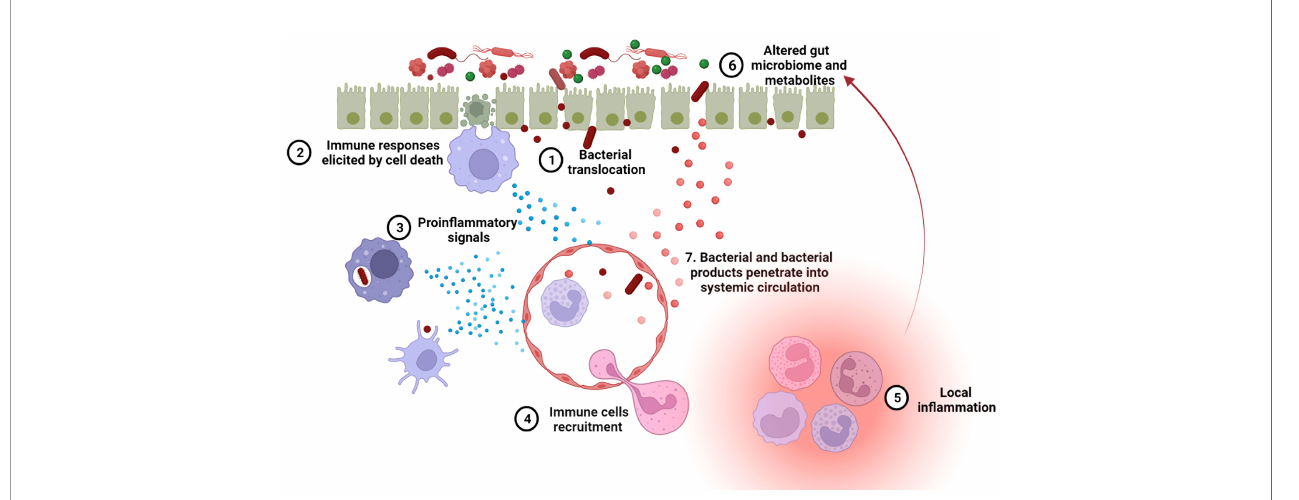
FIGURE 3 | A leaky gut exacerbates lupus progression. 1. Leaky gut-mediated bacterial translocation has been linked to the initiation of autoimmune responses. 2. Increased enterocyte cell death in leaky gut activates innate immune cells, inducing an overactive immune system. 3. The phagocytosis of invading bacteria by innate immune cells promotes in fl ammation. 4. Upon pro-in fl ammatory signaling, more immune cells are recruited to the leaky gut area. 5. Immune cell focal aggregation triggers local in fl ammation. 6. Enhanced local in fl ammation causes gut microbial dysbiosis and dysregulated fecal metabolites, both of which are related to lupus progression. 7. Bacteria and bacterial products can translocate into the blood stream through impaired blood vessels and then induce autoimmunity in systemic